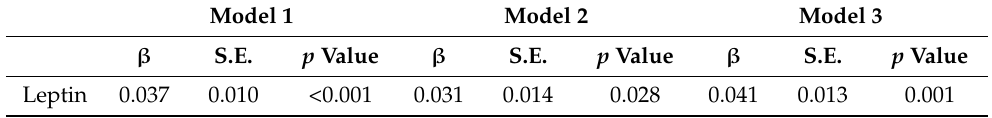
Table 4. Linear regression between the leptin–creatinine ratio and the HOMA-IR